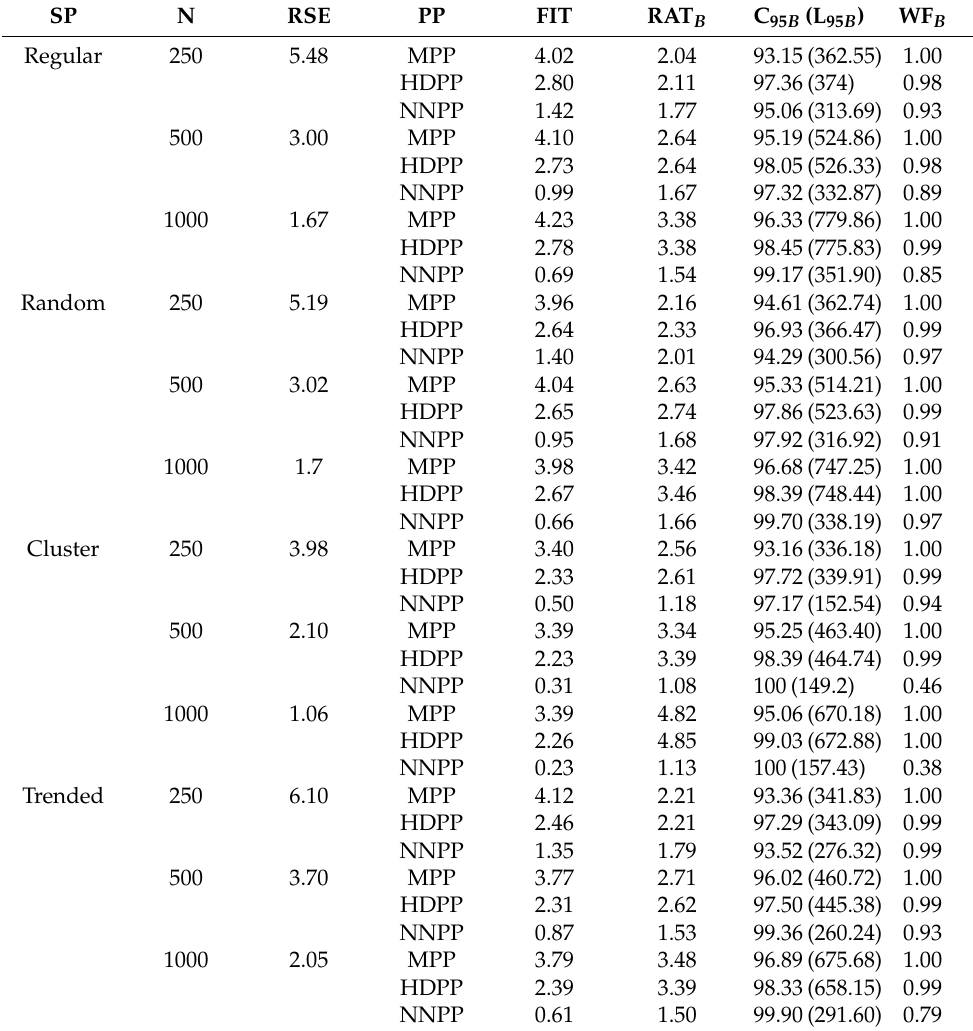
Table 2. Values of relative standard errors (RSE) of the Horvitz–Thompson estimator of totals, pseudo- population fitting indexes (FIT), ratios of expectations of bootstrap RSE estimators to the actual values (RAT B ), coverages of the 0.95 bootstrap confidence intervals (C 95 B ) and expectations (in parentheses) of their lengths (L 95 B ), and the worst of the two-sample Kolmogorov–Smirnov statistics (WF B ). The values are computed from R = 10,000 samples and B = 1000 bootstrap samples independently selected by means of the doubly balanced spatial sampling (DBSS) for each spatial pattern (SP), each pseudo-population (PP) and each populations size N = 250, 500, and 1000 with a sampling fraction of 0.1. SP N RSE PP FIT C 95 B (L 95 B )